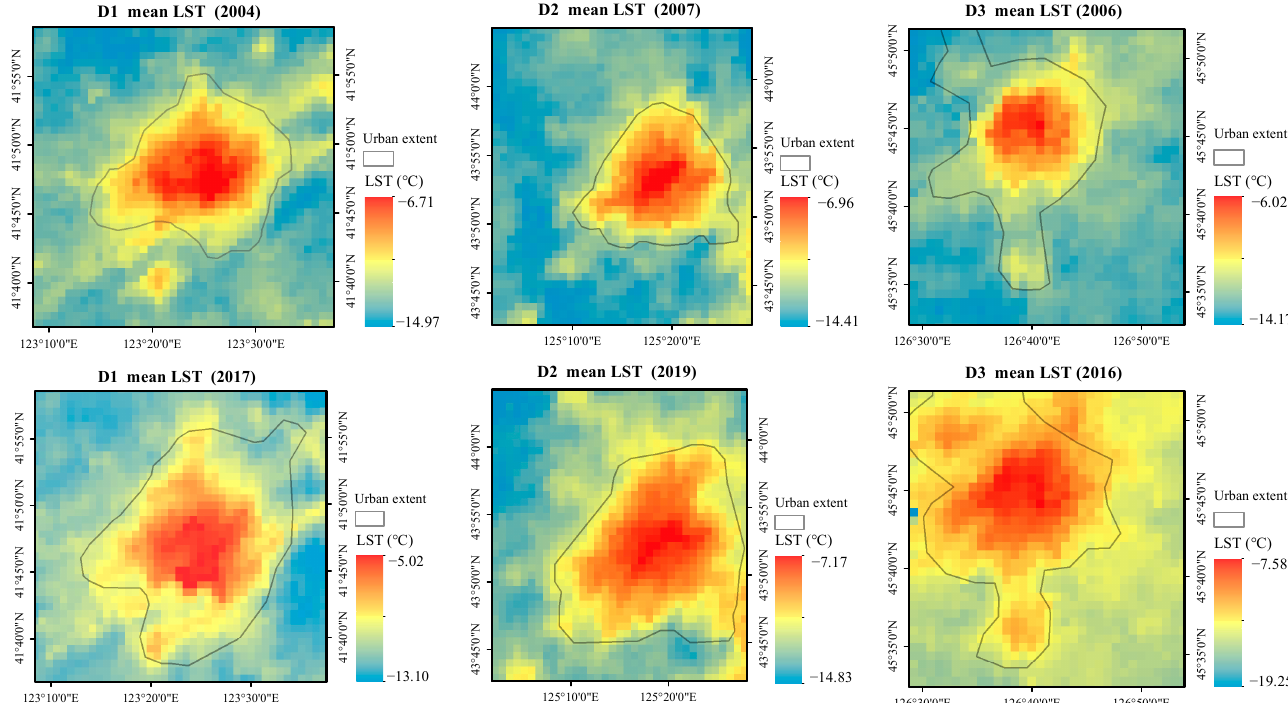
Figure 14. The spatial distribution of the mean land surface temperature (mean LST). The correlations results between changes in the EHIA, AHI, and ISA are shown in Figure 15. In the three study areas, the time series changes of the EHIA are all positively correlated with the ISA. For D1, the correlation coefficient is 0.87; in D2, it is 0.97; and in D3, it is 0.87. The time series changes of the AHI are positively correlated with the ISA.